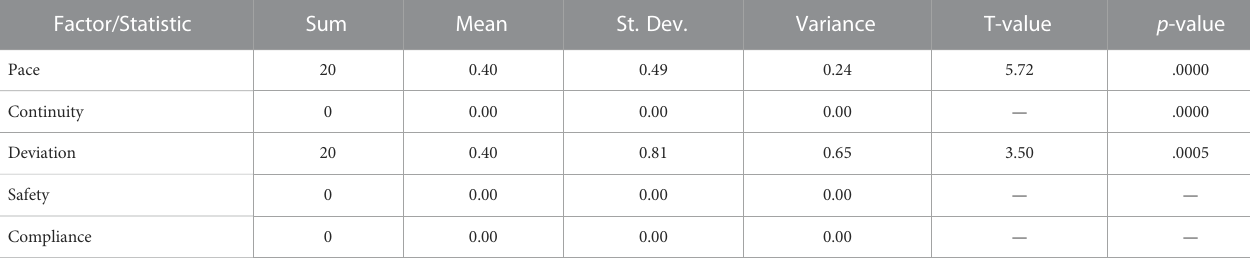
TABLE 7 Descriptive statistics of the performance factor in scenario 3: Road Narrowing.